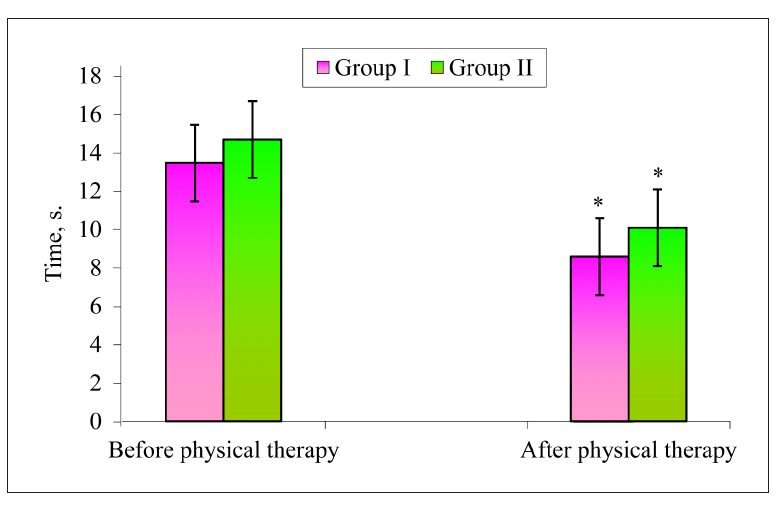
groups.Figure 3. The 6-minute walk distance in meters before and after physical therapy in Group I and Group